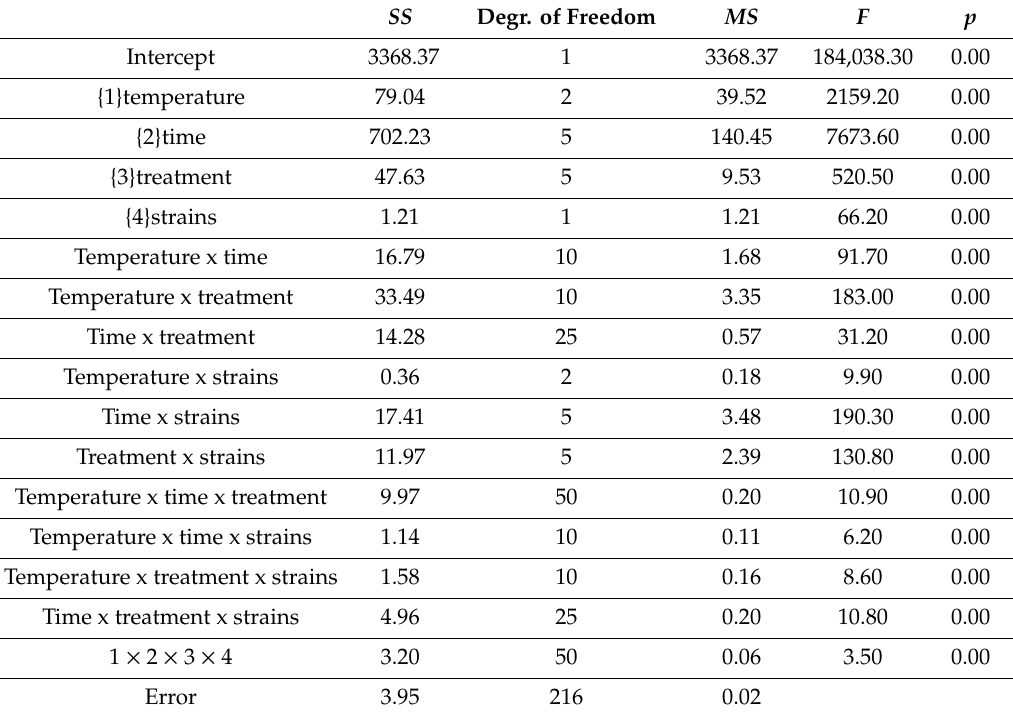
Table 4. Standardized e ff ects of strains, storage temperature, treatments (US and thermal abuse, see Table 2) and time on acidification. The results were obtained by MANOVA (analyses of variance) and Tukey’s test ( p < 0.05) as the post hoc comparison test.